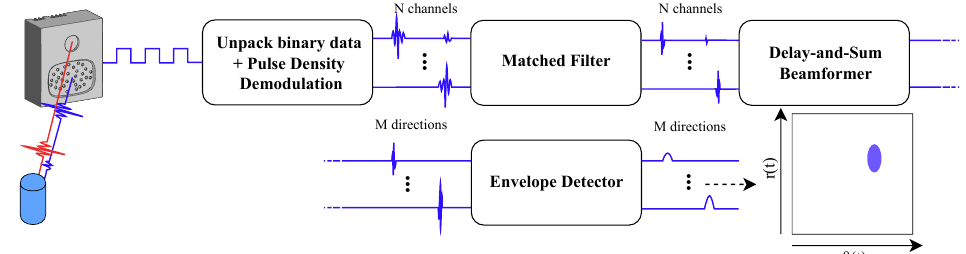
Figure 2. Diagram of the digital signal processing steps to go from the raw microphone signals to the energyscapes. The initial signals containing the reflections of the detected objects are first demodulated to the full audio signals of the N channels. A matched filter is used for finding the actual reflections of the emitted signal. Delay-and-sum beamforming creates a spacial filter for every direction of interest. Subsequently, envelope detection is used to clean up the spatial